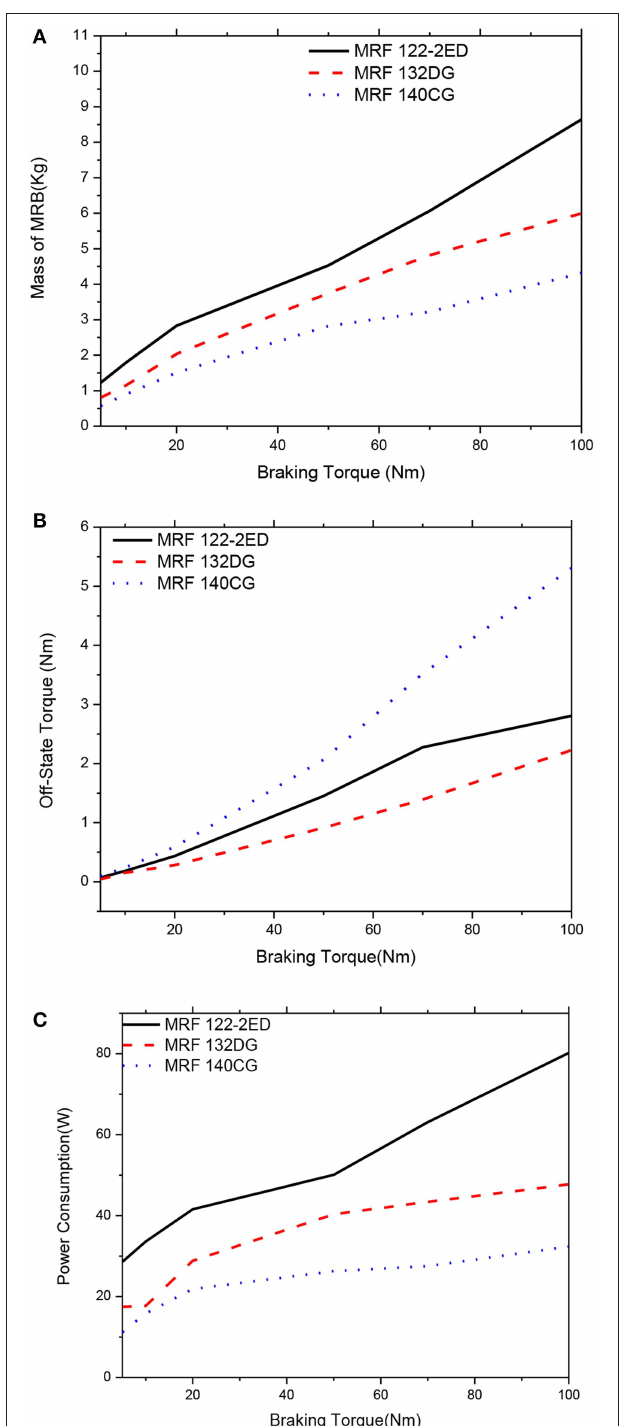
FIGURE 18 | Multi-objective optimization results of the MRBs as a function of braking torque of conventional MRB, α m = 0.75 ; α P = 0.0 ; α To = 0.25. (A) Mass as a function of braking torque, (B) Power consumption as a function of braking torque, (C) Off-state torque as a function of braking torque.